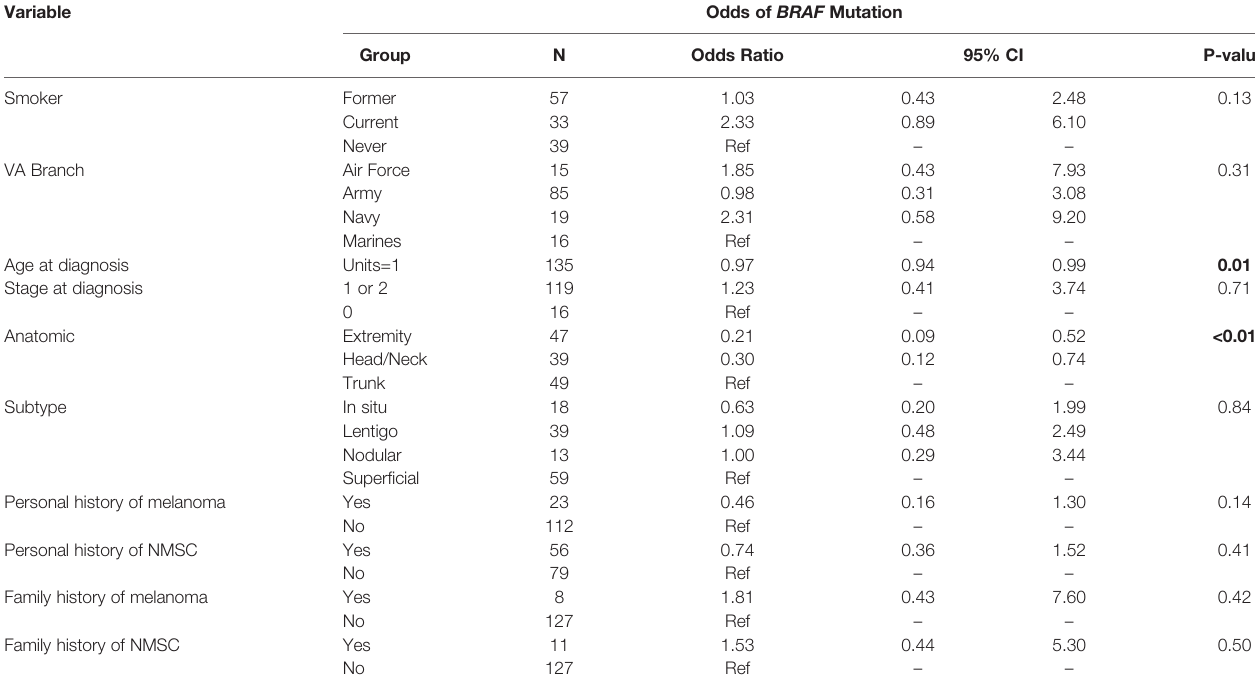
TABLE 4 | Univariate analysis between demographic and clinical factors and BRAF mutations. Variable